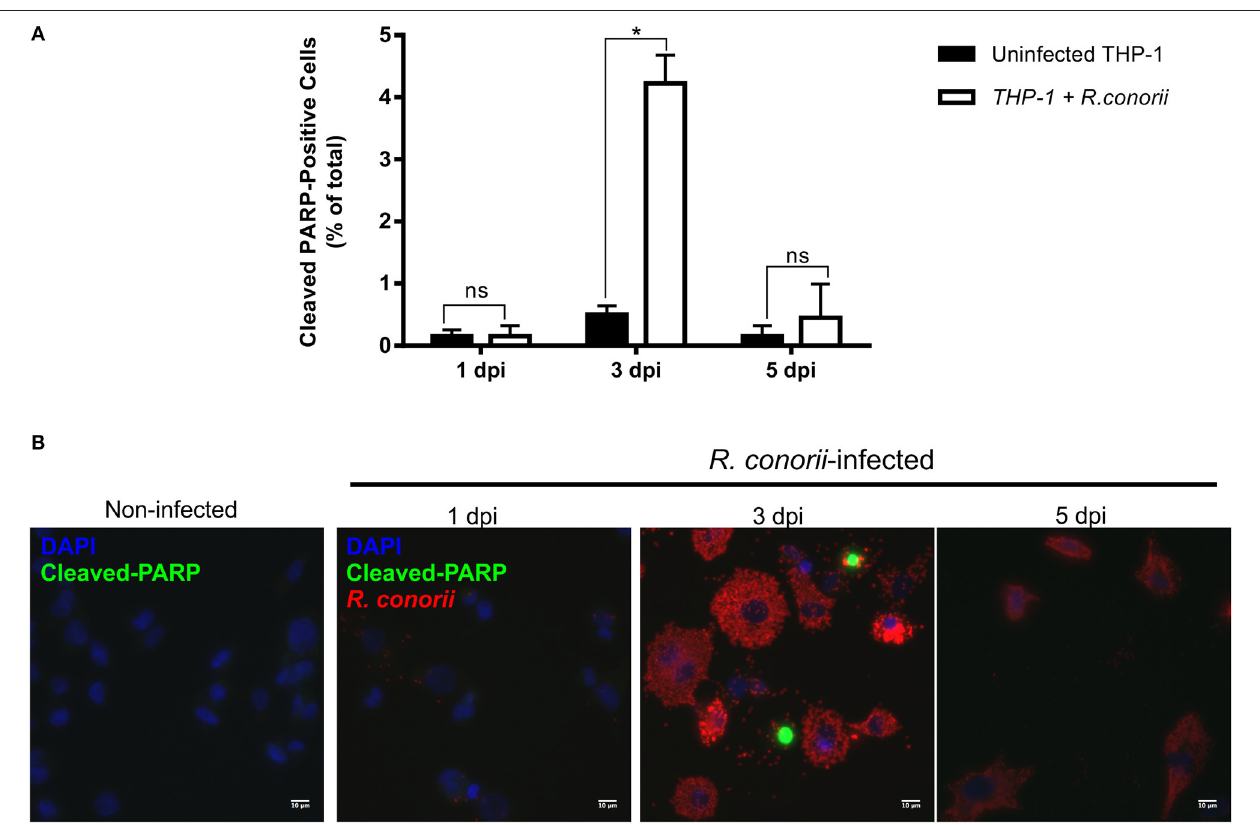
FIGURE 6 | Rickettsia conorii modulates host cell apoptosis during infection. (A) Percentage of cleaved PARP-positive cells, a marker of intrinsic apoptosis, over the course of infection of THP-1 macrophages with R. conorii . Results are shown as the mean ± SD and differences were considered non-significant (ns) at P > 0.05 or significant at * P < 0.05. (B) Immunofluorescence microscopy of uninfected cells and THP-1 macrophages infected with R. conorii at 1, 3, and 5 days post-infection. Cells were stained with DAPI (blue) to identify host nuclei, mouse anti- Rickettsia antibody (5C7.31) followed by anti-mouse Alexa Fluor 594 (red) to identify R. conorii and rabbit anti-cleaved poly(ADP-ribose) polymerase (PARP) followed by anti-rabbit Alexa Fluor 488 (green) to identify cleaved PARP-positive cells. Scale bar = 10 µ m.